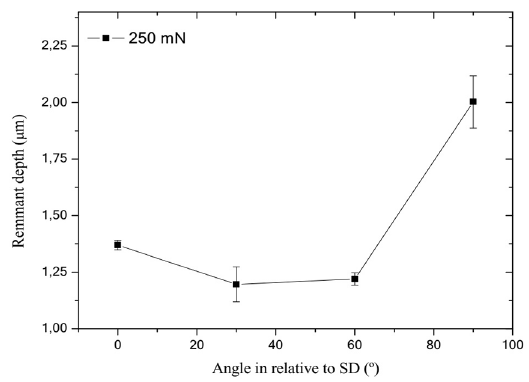
Figure 6. Remnant depth as a function of solidification direction.